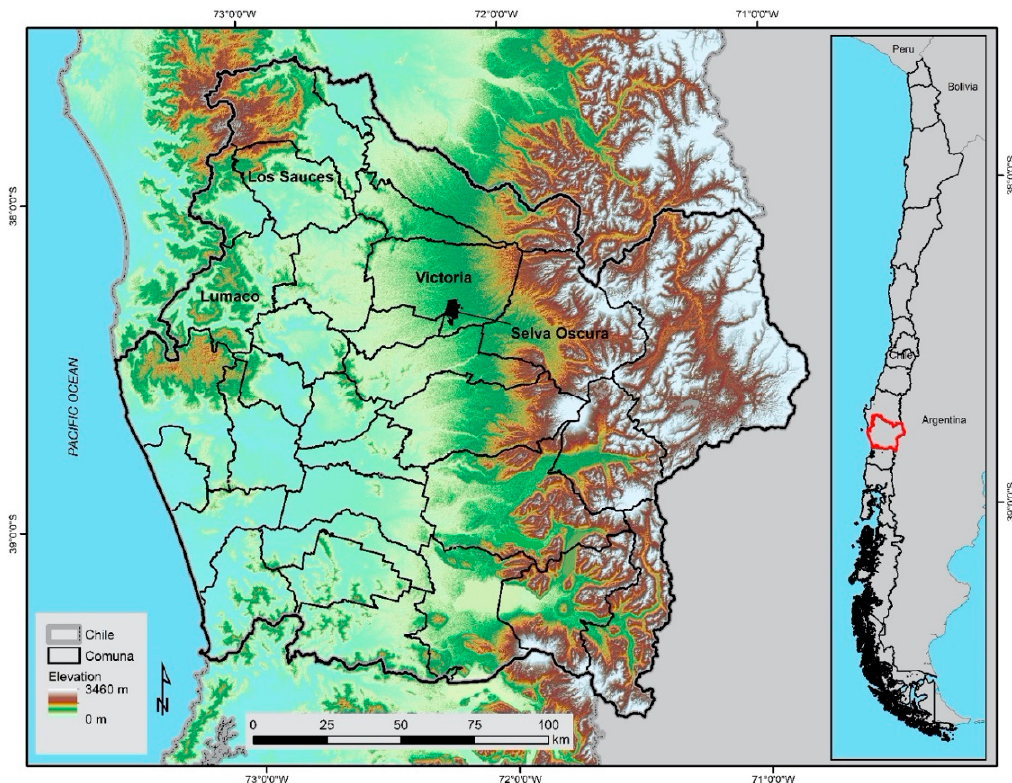
Figure 1. The Study Region, La Araucanía, Chile, and its comunas . Place names mentioned in the text are labeled. Data sources: Political boundaries from Infraestructura de Datos Geospaciales of Chile and ASTER GDEM from United States Geological Survey (USGS) AppEEARS. Created by Molly H. Polk.